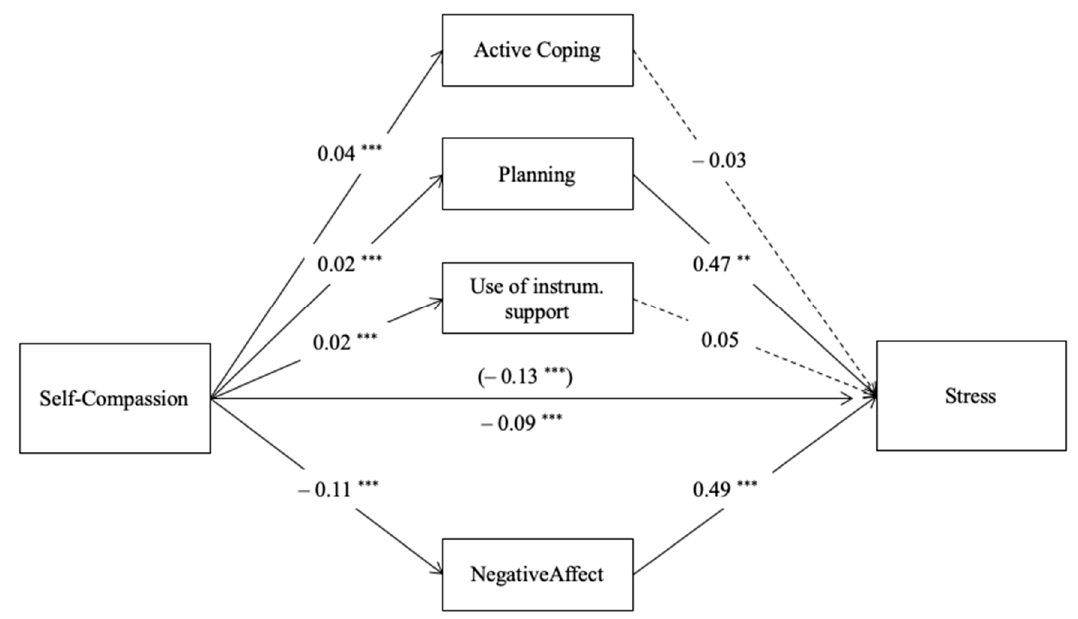
Figure 4. Parallel mediation model with path coefficients (unstandardized): self-compassion, negative affect, active coping, planning, use of instrumental support coping and stress. Note: ** p < 0.01, *** p < 0.001, c’ (direct effect) above the line and c (total effect) below the line, dashed lines are not-significant paths.